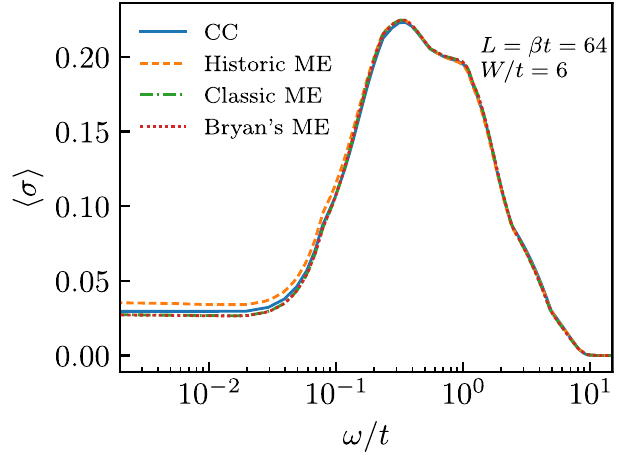
Fig. 5 Comparison of analytic continuation algorithms on disorder- averaged data. Disorder-averaged optical conductivity 〈 σ ( ω ) 〉 as a function of the frequency for different analytic continuation algorithms including, consistent constraints (solid blue), and three different variants of the maximum entropy method: historic (dashed yellow), classic (dash-dotted green), and Bryan ’ s method (dotted red) [see ref. 41 ]. Data were shown for L = β = 64 and W = 6. The average is taken over all 384 disordered